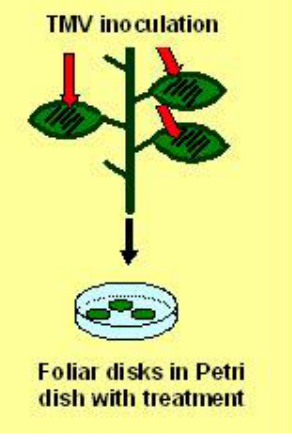
FIGURE 8. Tobacco/TMV model; schematic representation of the experimental